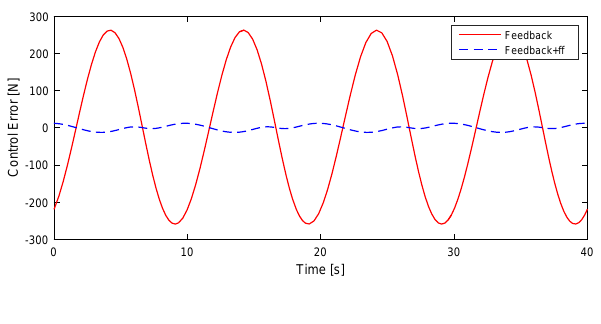
Figure 5: Force set point of 0 kN.